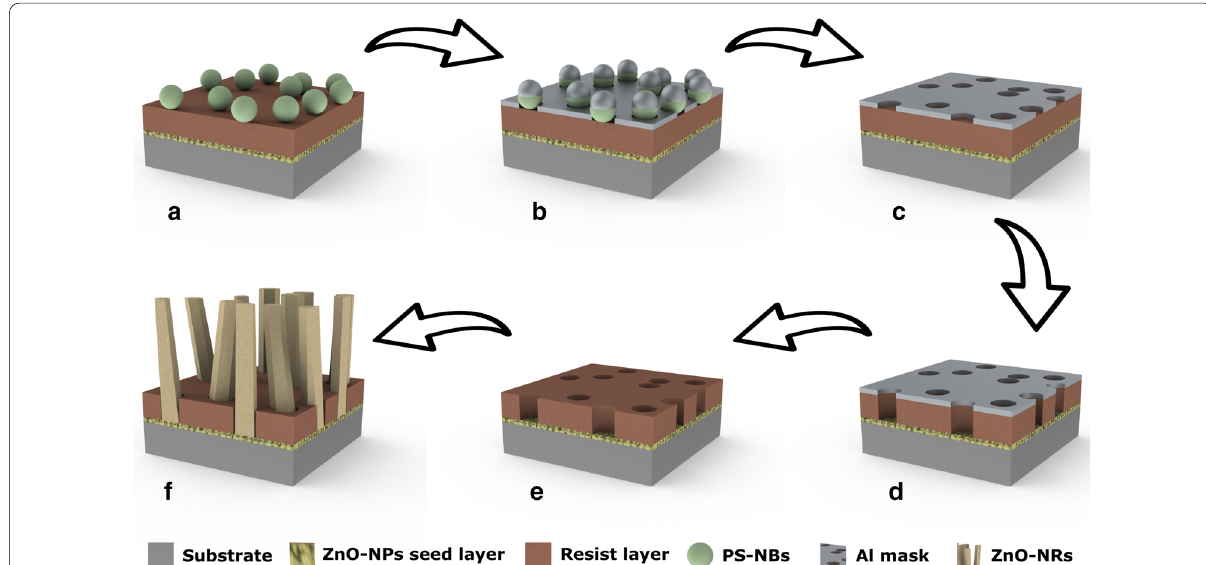
Fig. 1 Schematic of the fabrication process steps to synthesize vertically aligned ZnO NR arrays. a A substrate coated with a ZnO NP seed layer, a polymer resist layer and PS-NBs. b Thermal evaporation of an Al mask. c Removing the Al-coated PS-NBs by tape stripping. d Dry etching of the resist. e Wet etching of the Al mask. f Selective ZnO NR growth in the holes of the patterned resist